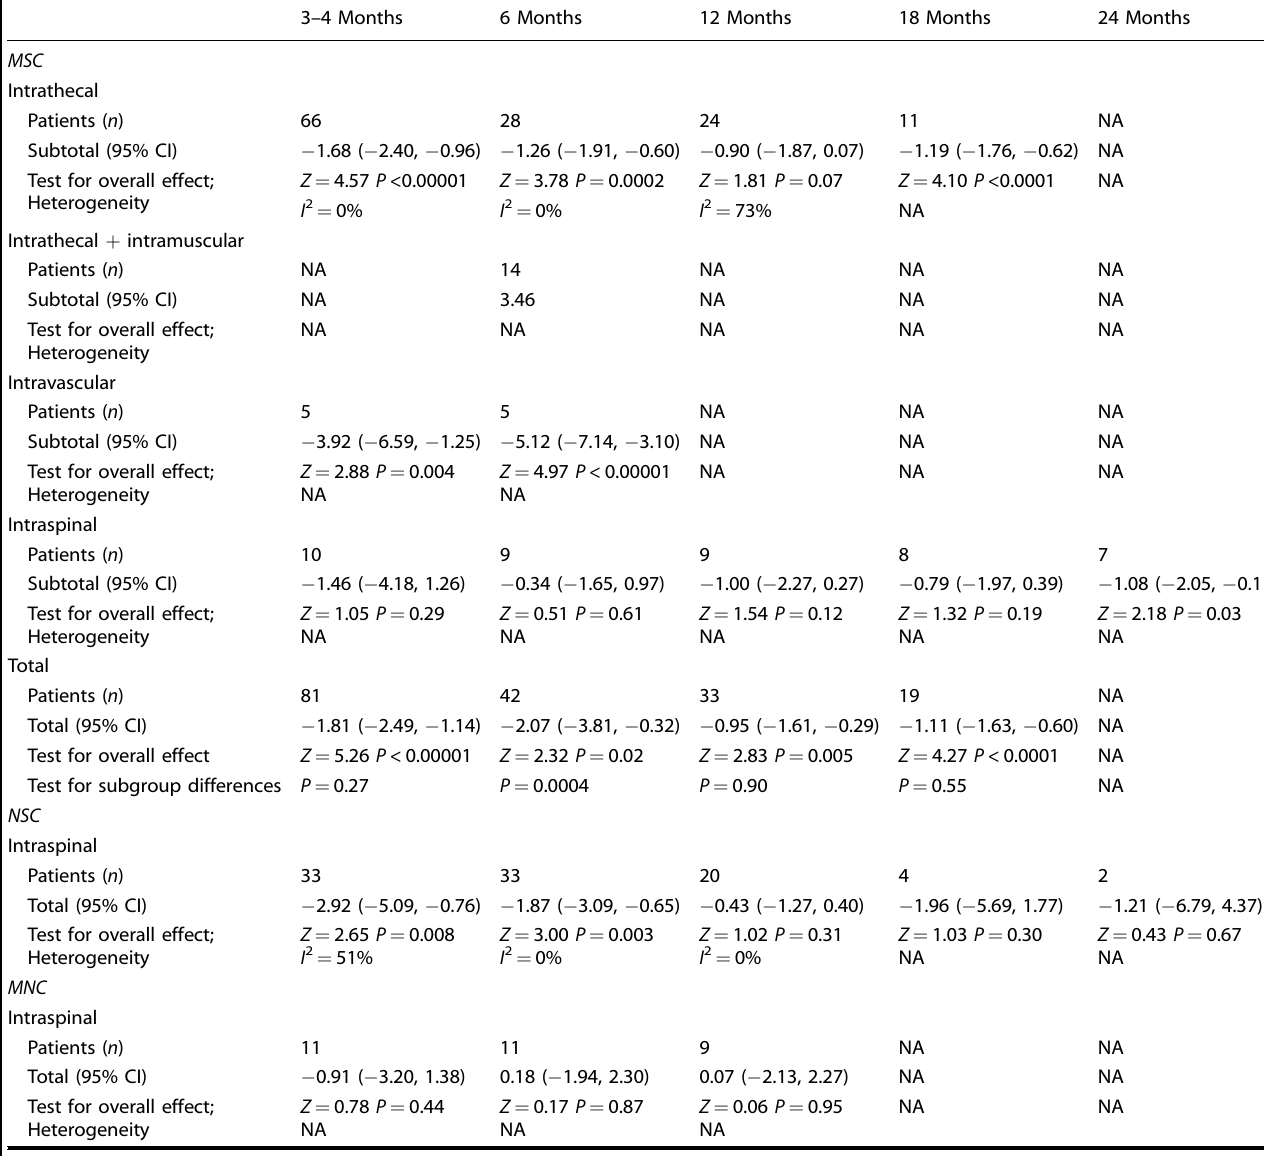
Table 3. Differences in FVC change per month between the lead-in and follow-up